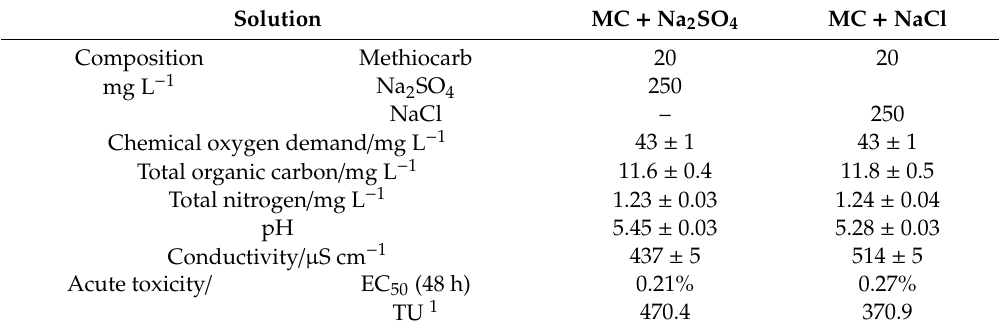
Table 1. Composition and characterization of the methiocarb aqueous solutions used in the